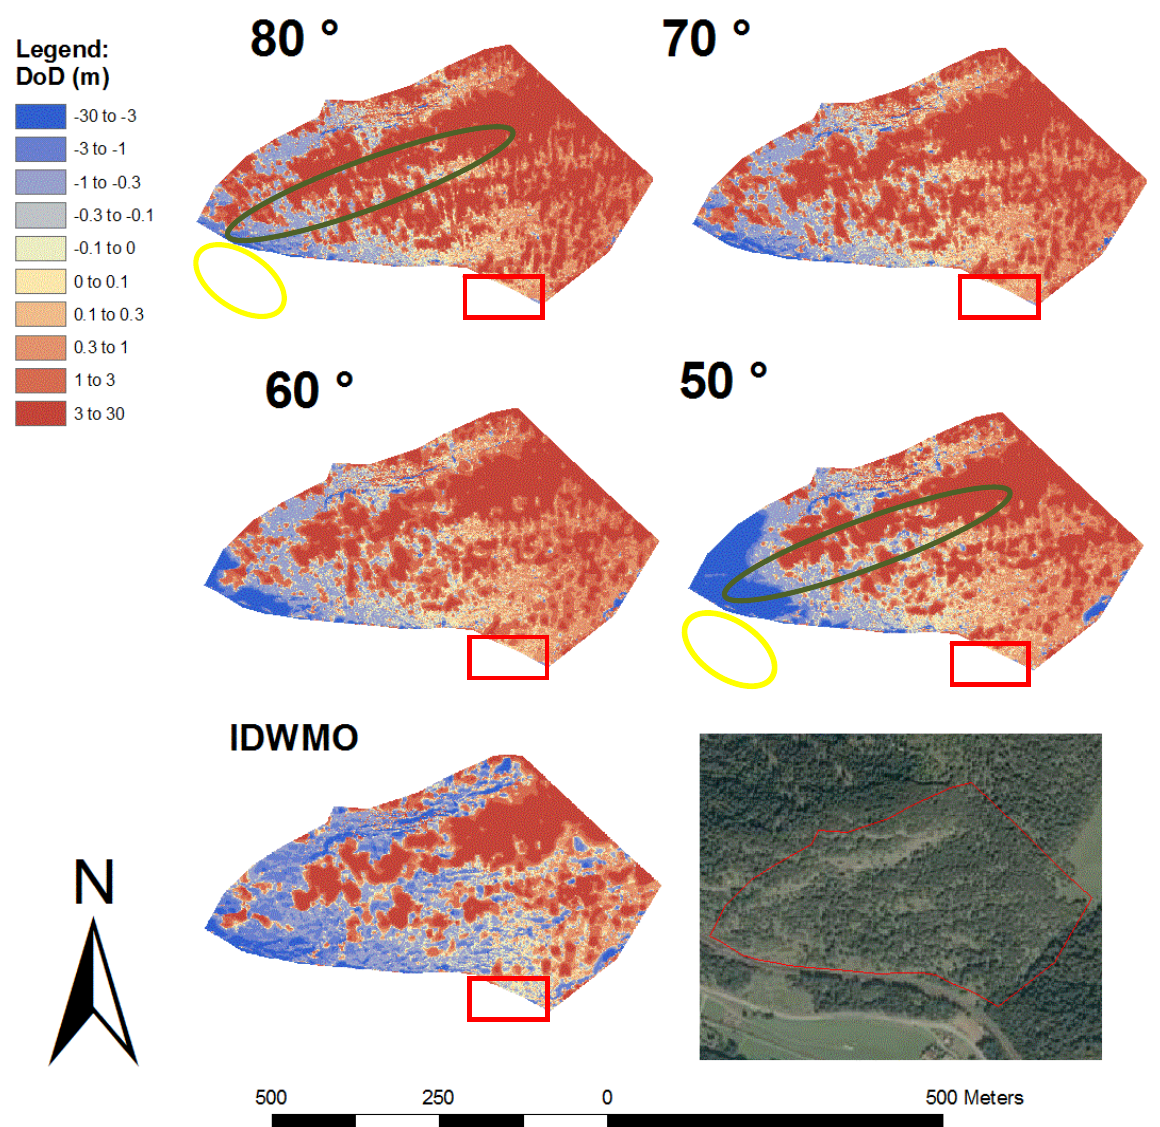
Figure 10. Differences of the first test area between the new calculated terrain models (filter angles 80, 70, 60 and 50 degrees) and the manually filtered terrain model (m). Red rectangle indicates the area of high point